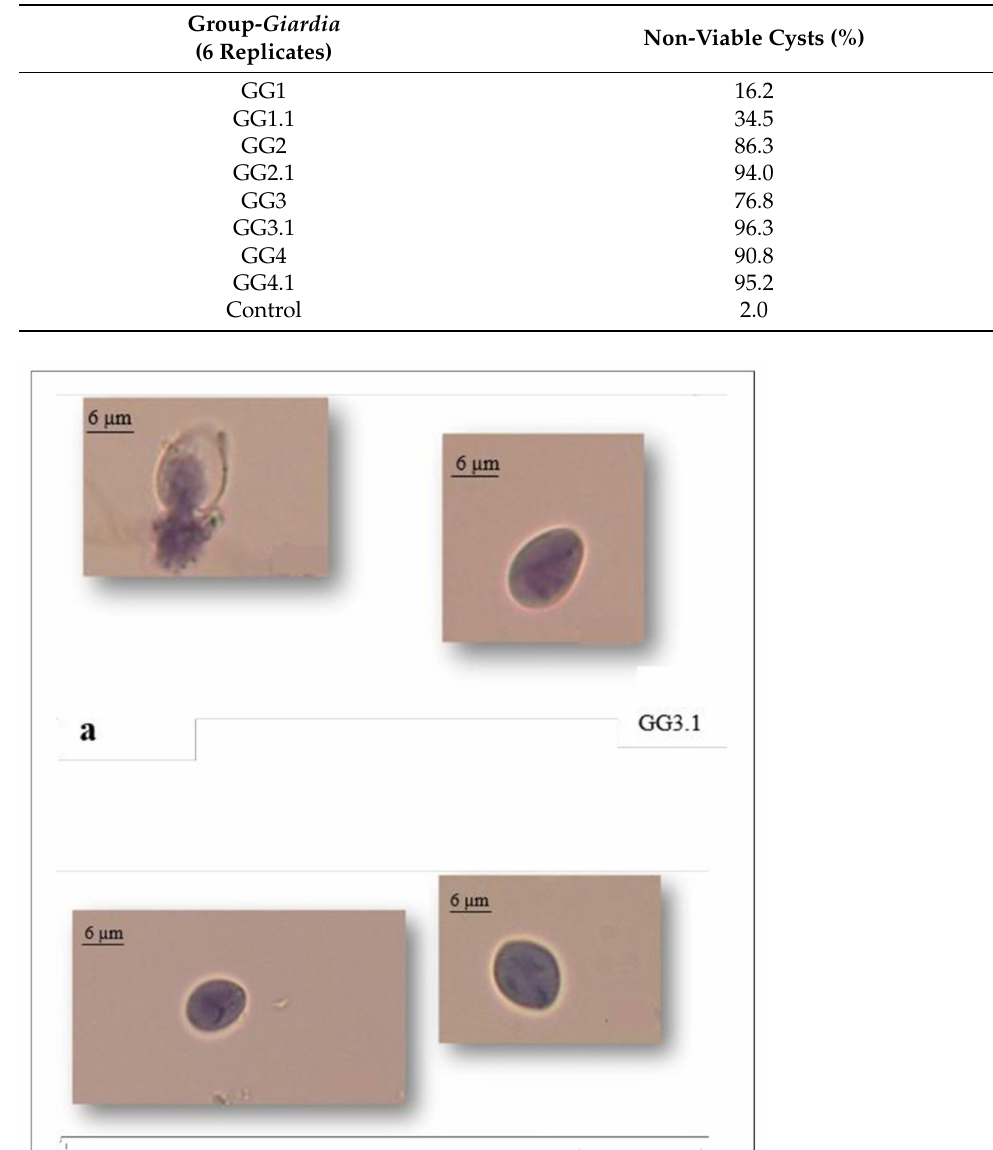
Table 4. Effect of ozone on the Giardia duodenalis cyst viability.